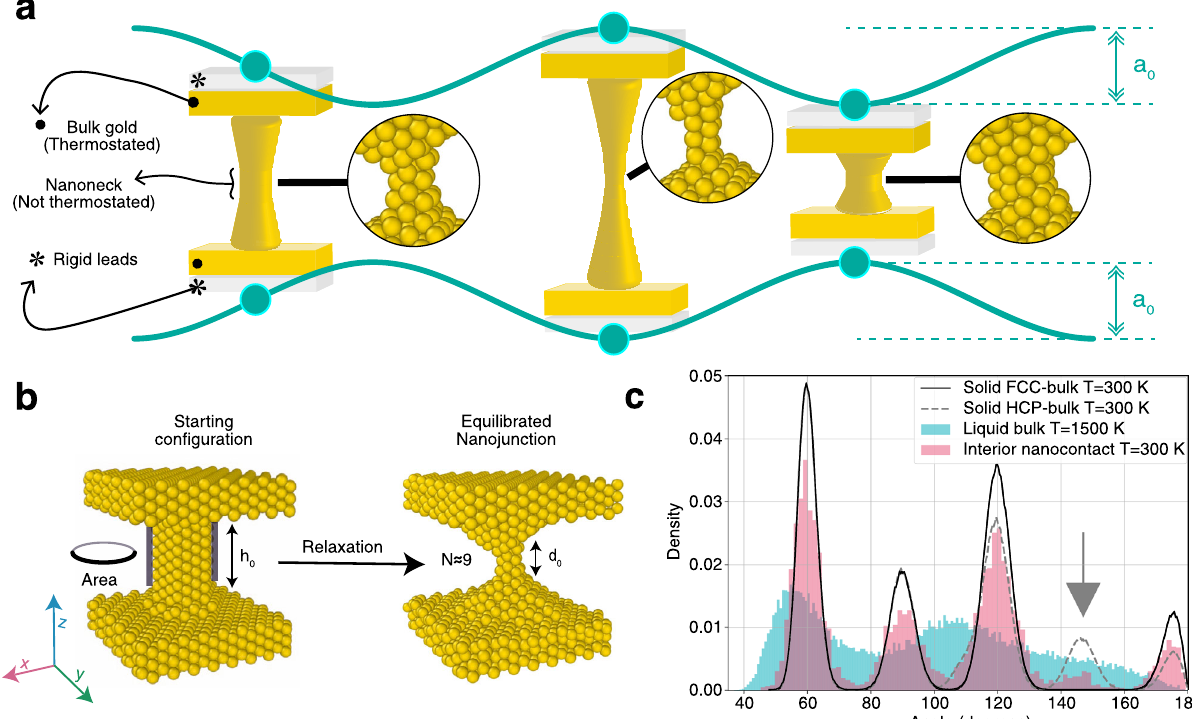
Fig. 1 Simulated rheology of an oscillating solid metal nanocontact. a Sketch of a gold nanojunction under oscillatory strain, exerted through crystalline leads at room temperature. b Snapshots of a nanocontact ( N ≈ 9 atom cross section) of initial crystalline columnar shape (left) and quasi-equilibrium working shape obtained after extended structural relaxation (right). Note the anvil-like tips formed on both sides of the effective nanojunction's neck reducing its effective length from h 0 to d 0 . c Three-body angular distribution of inner core atoms of the relaxed junction measured during ≈ 10 strained cycles at the largest oscillatory amplitude (0.22 nm). The main peaks con fi rm the survival of fcc structure and coordination of the nanocontact core. The small structure around 147 ∘ (arrow) is a signature of the (111)